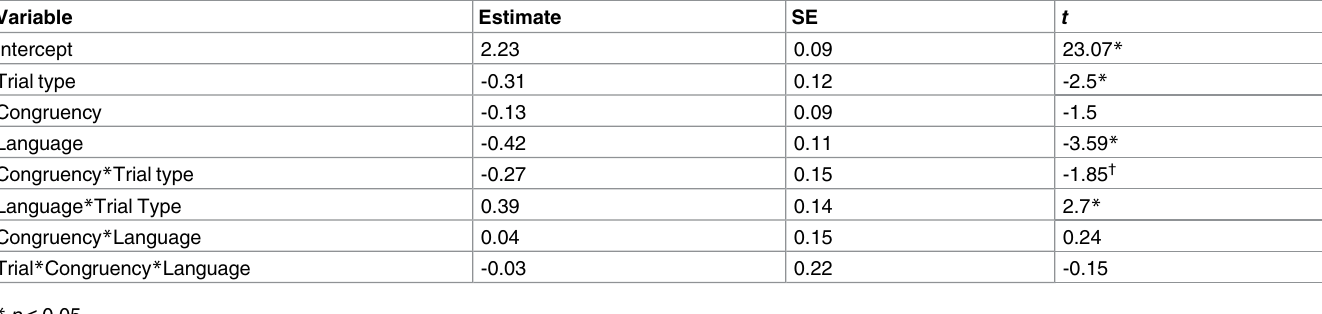
Table 5. Results on choice data (Experiment